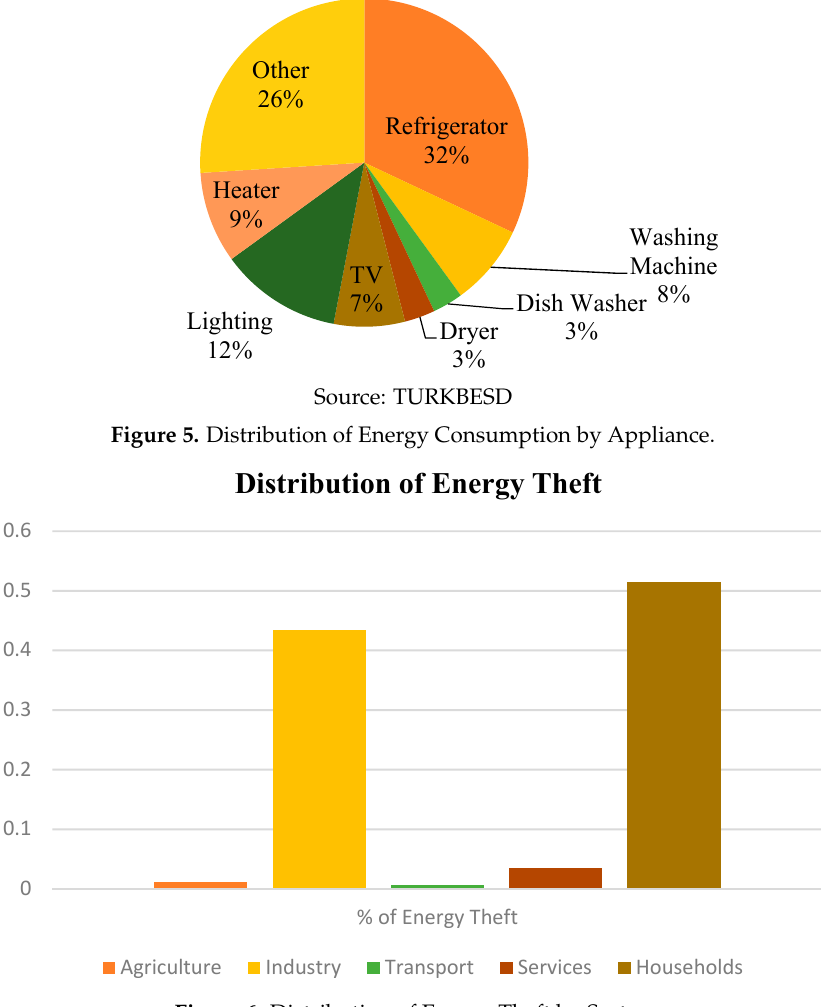
Figure 6. Distribution of Energy Theft by Sector.